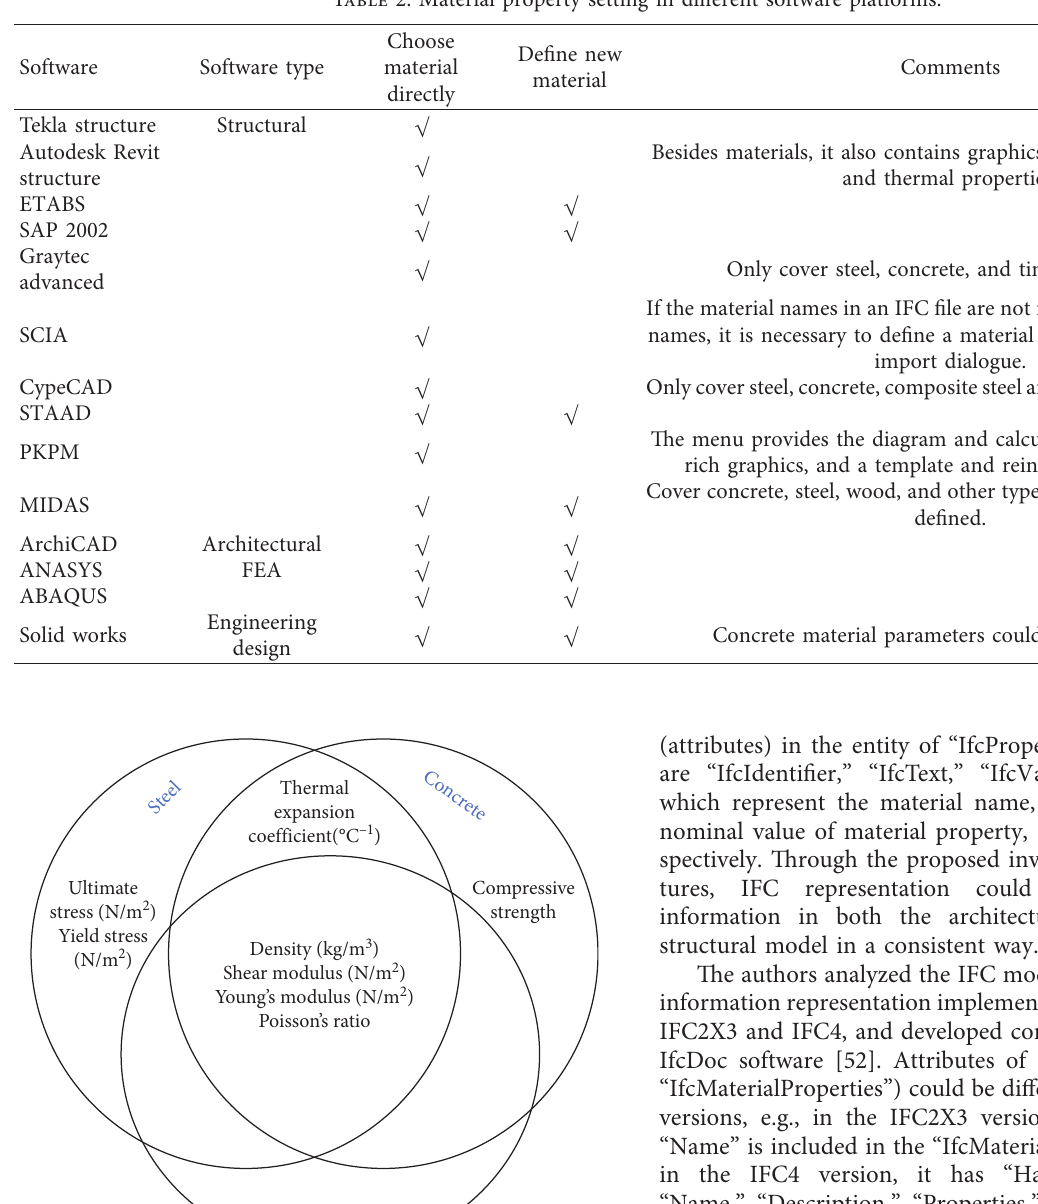
Table 2: Material property setting in different software platforms.